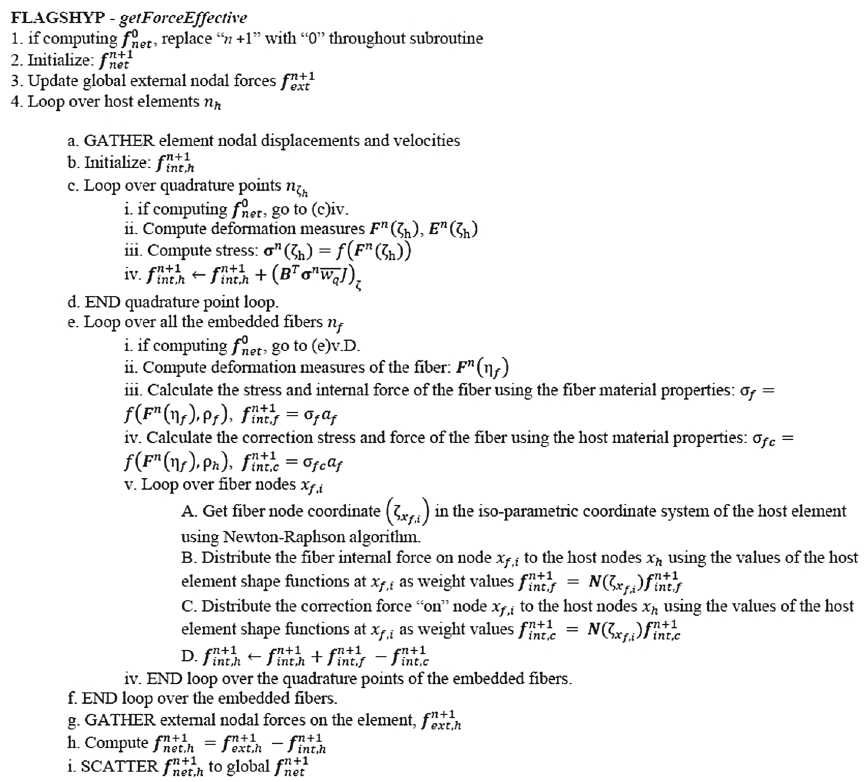
Fig. 4 Modified algorithm for the getforce subroutine that includes the interaction between the embedded element internal forces and the host element